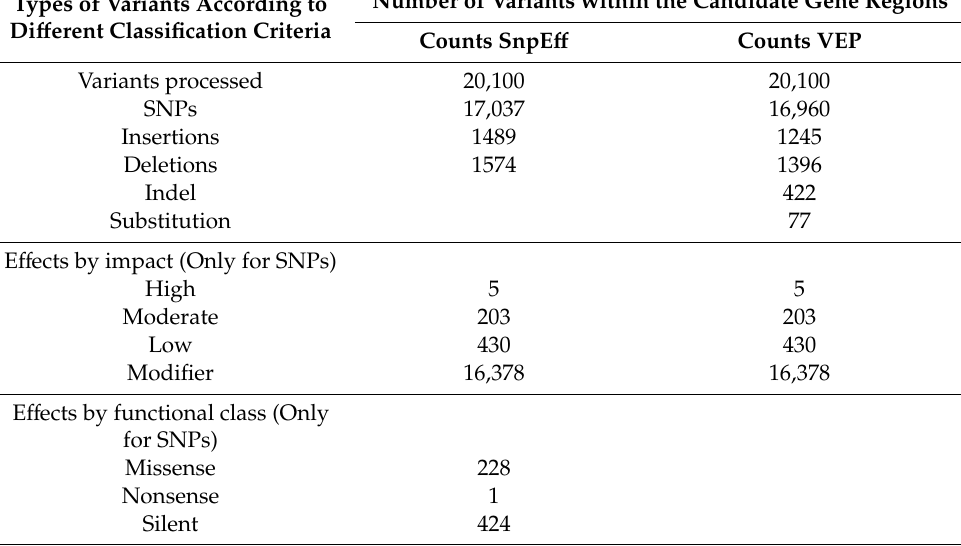
Table 1. Summary statistics of the annotation analyses performed with the SnpE ff and VEP software for the genetic variants identified within the studied candidate gene regions through the analysis of the WGR datasets here